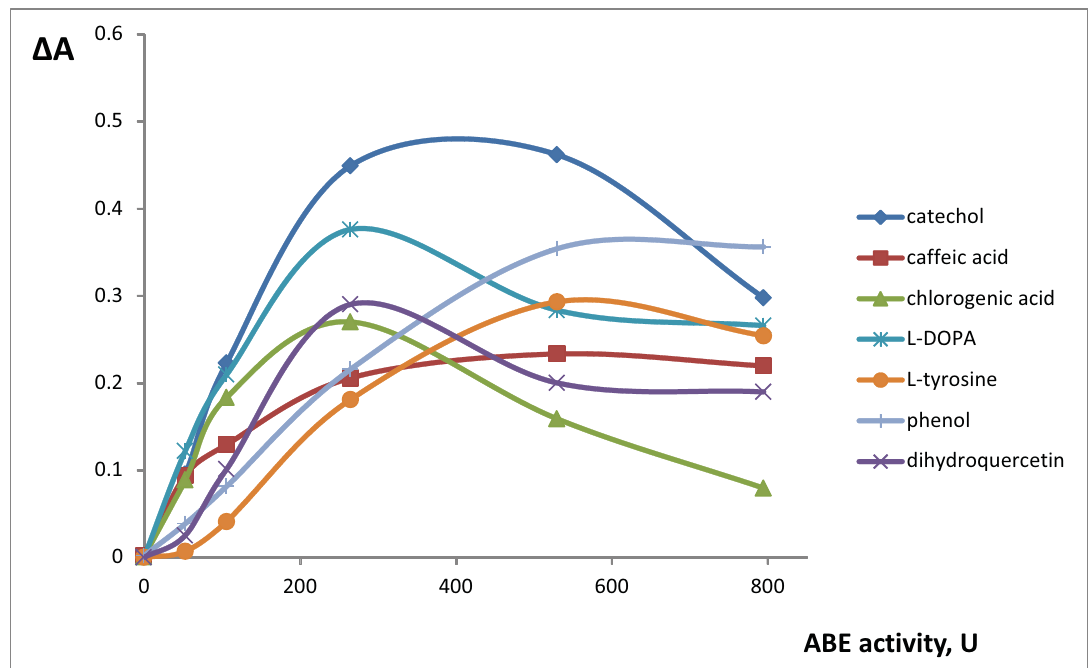
Figure 4. Influence of ABE activity on the oxidation reaction speed ( ∆ A = A 270 s − A 30 s for catechol, ca ff eic acid, chlorogenic acid, dihydroquercetin, and l -DOPA; ∆ A = A 60 min − A 10 min for l -tyrosine and phenol). C (substrate) = 1.0 × 10 − 3 M, pH = 4.8 for catechol, ca ff eic acid, and chlorogenic acid, pH = 7.2 for dihydroquercetin, l -DOPA, l -tyrosine, and